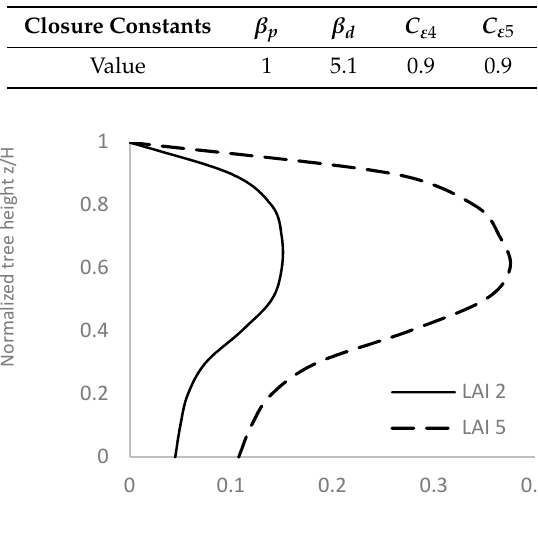
Table 2. Constants used for the canopy model.